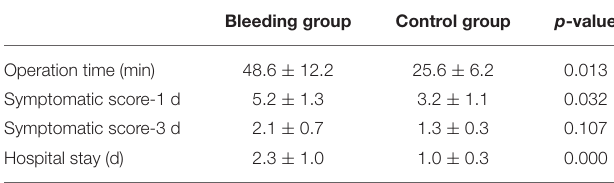
TABLE 4 | Treatment effectiveness of MWA for cystic thyroid